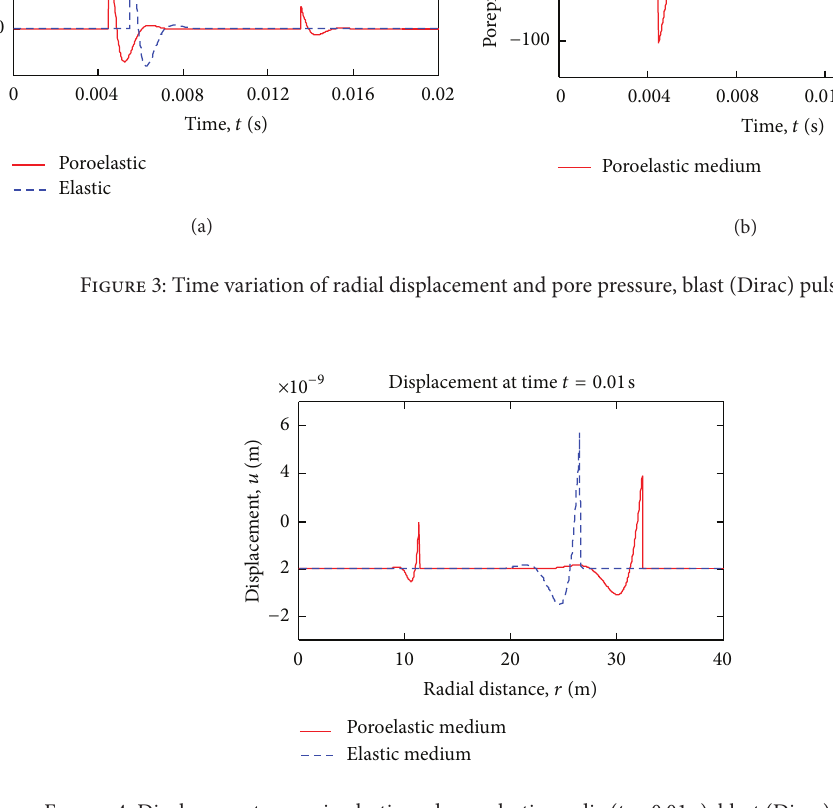
Figure 4: Displacement waves in elastic and poroelastic media ( 𝑡 = 0.01 s), blast (Dirac) pulse